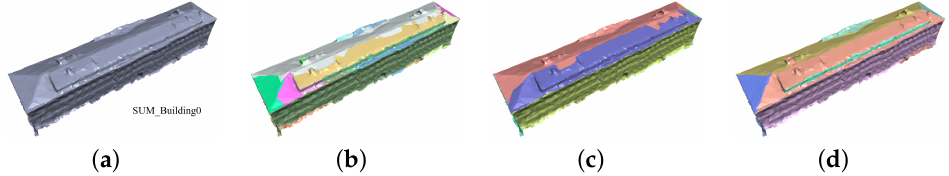
Figure 3. Comparison of segmentation results: ( a ) Original, ( b ) Strict threshold, ( c ) Relaxed threshold, and ( d )